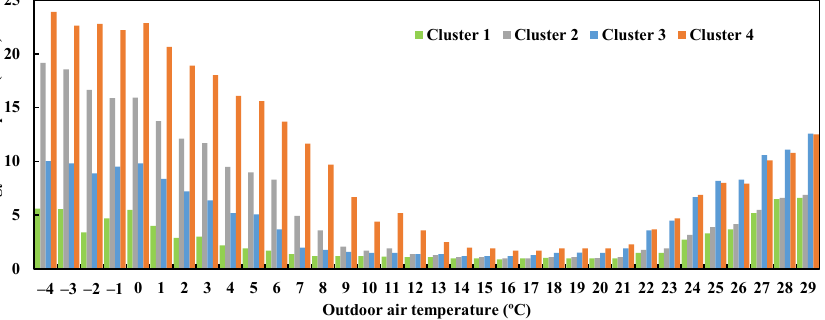
Figure 12. Average energy consumption of each dormitory at different outdoor air temperature intervals.